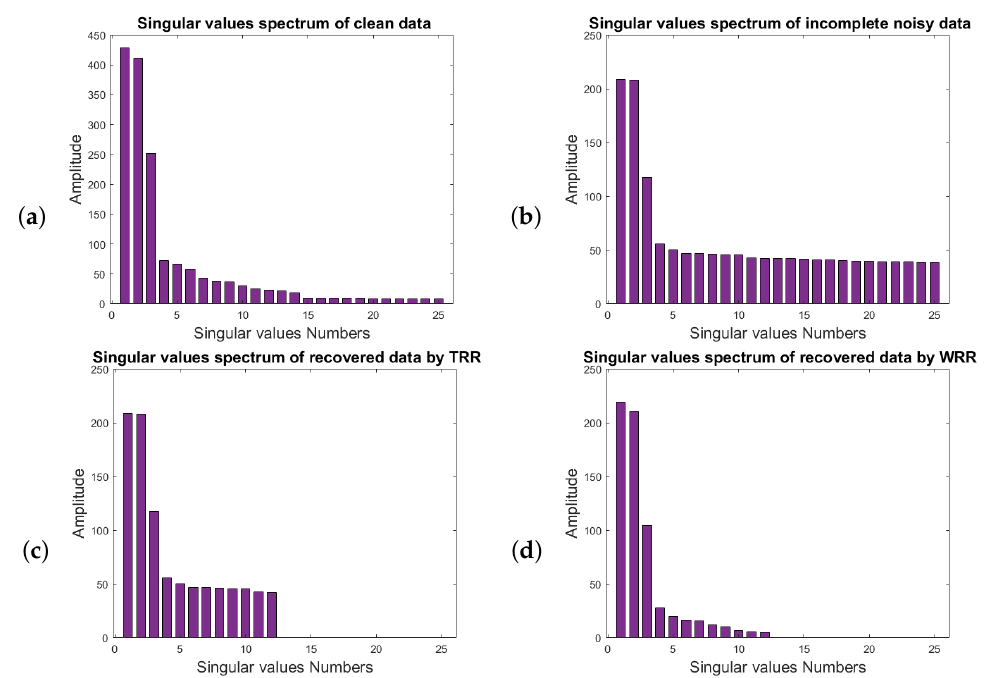
Figure 8. The spectrum of the first 25 singular values of the block Hankel matrices for frequency of 20 Hz for ( a ) clean and complete data and ( b ) data with SNR = 2 and 51% missing traces; ( c ) the first 12 singular values of the data; ( d ) singular-value spectrum of the data after applying the weighting